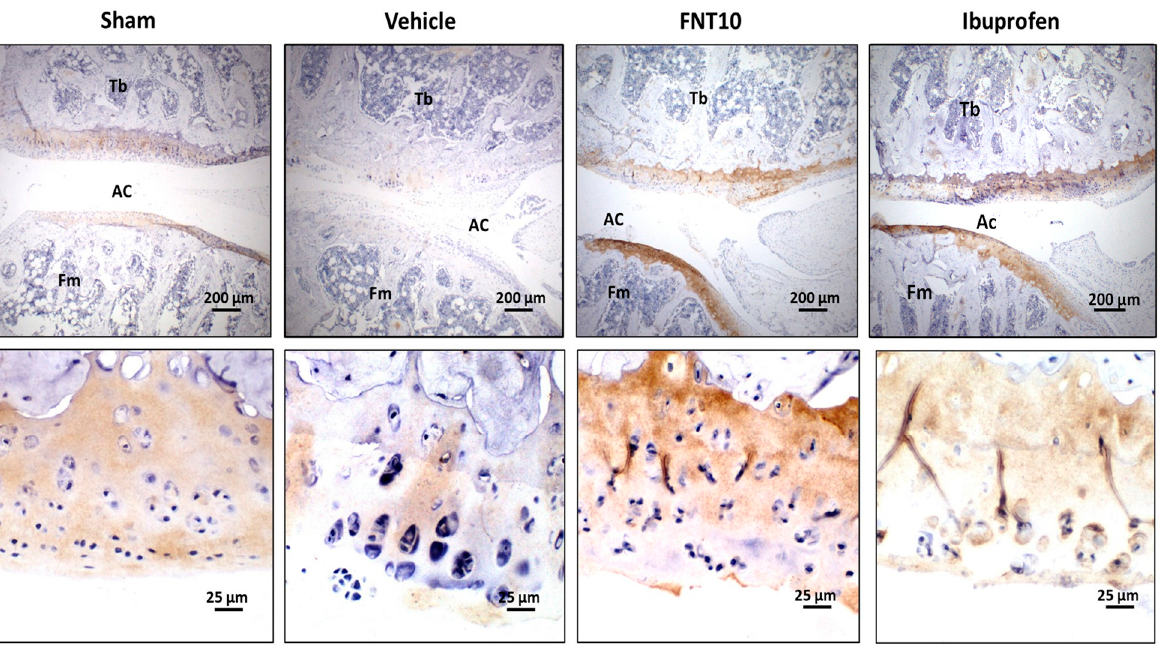
Figure 2. Immunohistochemical expression of collagen type II in the tibial articular surfaces in the experimental groups. Upper row of pictures shows a panoramic view of the tibial–femoral joint (40 × ), whereas the lower row presents detailed images of the tibial surfaces (400×). Group Sham showed a homogeneous immunoreactivity along the articular surface and the epiphyseal cartilage, whereas Group Vehicle presented a sparse and irregular immunoreactivity pattern, limited to some focal areas of the specimens. The groups treated with formononetin at 10 mg/kg (Group FNT) and ibuprofen showed strong staining at the deepest two ‐ thirds of the epiphyseal cartilage, and progressive loss of immunoreactivity in the most superficial first ‐ third. Legend: AC—articular cavity; Tb—tibial bone; Fm—femoral bone.